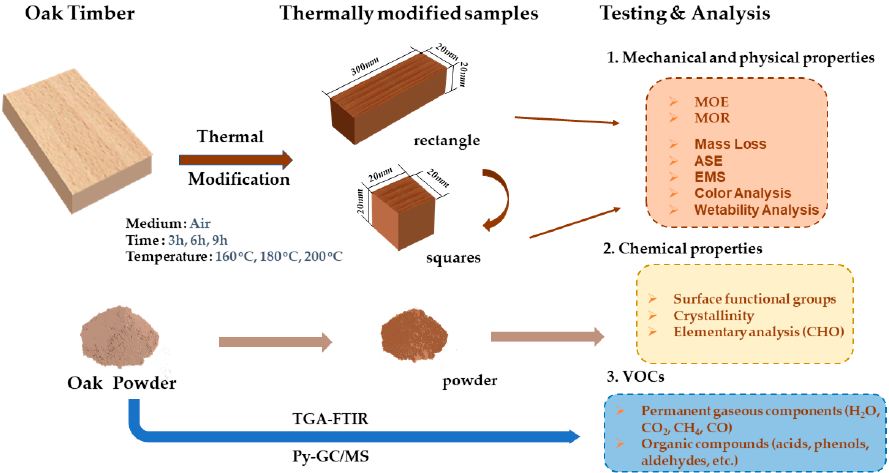
Figure 1. Flow diagram of wood thermal modification experiment.